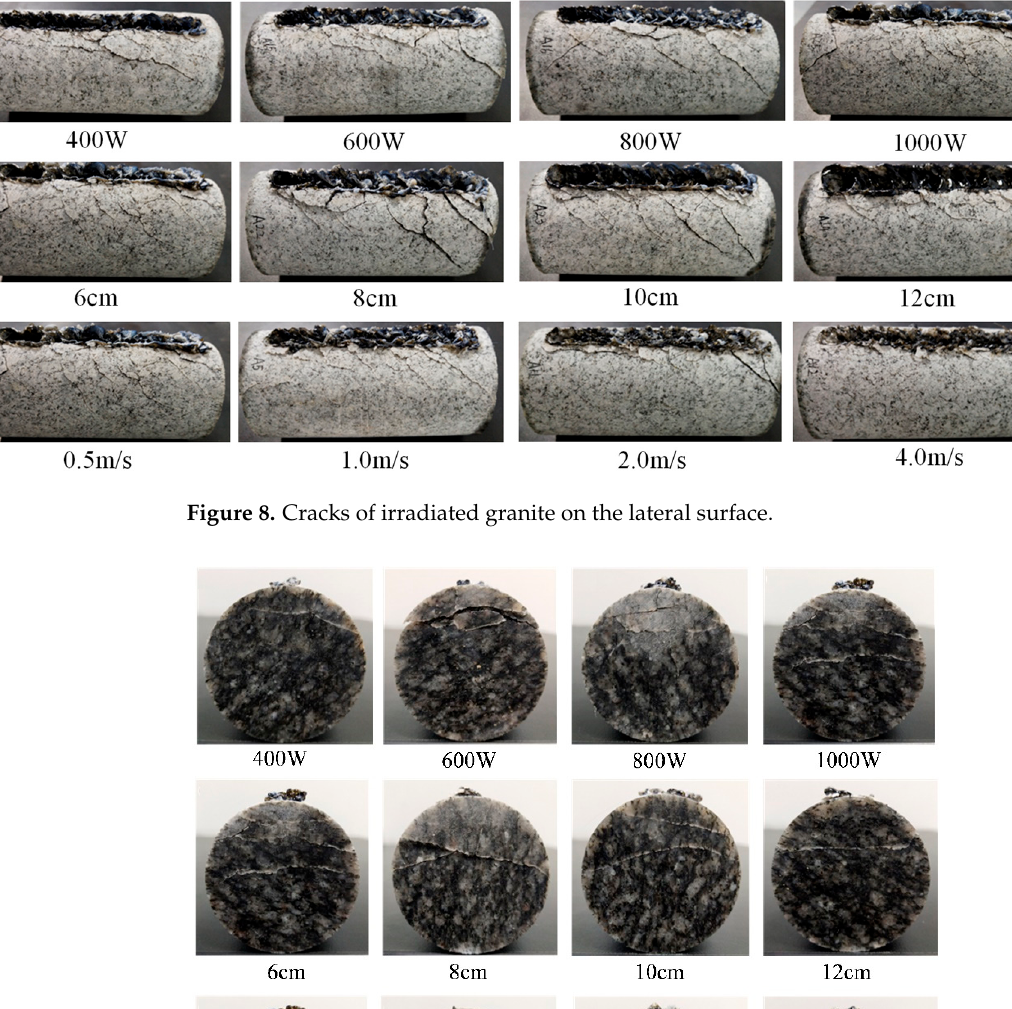
11 of 17 Figure 7. Wave form versus ( a ) original specimen, laser powers of ( b ) 600 W and ( c ) 1000 W, beam